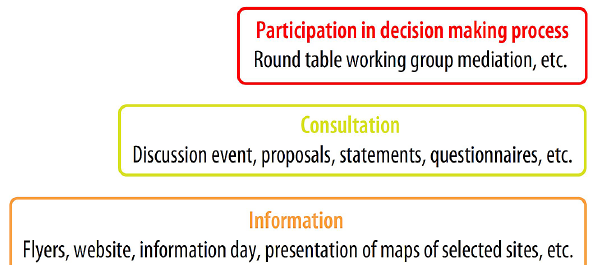
Fig. 1. Intensity degrees of participation processes (source: after Arbter et al, 2005, p.